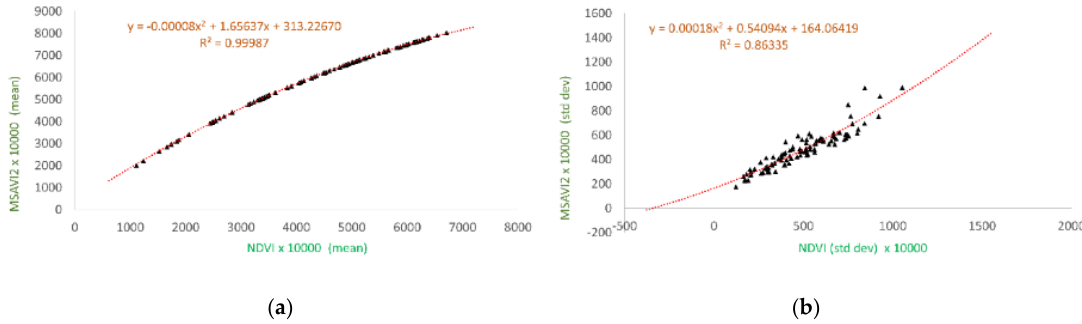
Figure 3. Comparison between NDVI and MSAVI2 mean values ( a ) and standard deviations ( b ). All data computed for each of the 4 vineyards were jointly considered. Vegetation spectral properties described by the two indices were not different. Normalized difference vegetation index (NDVI); modified soil-adjusted vegetation index, version two (MSAVI2).